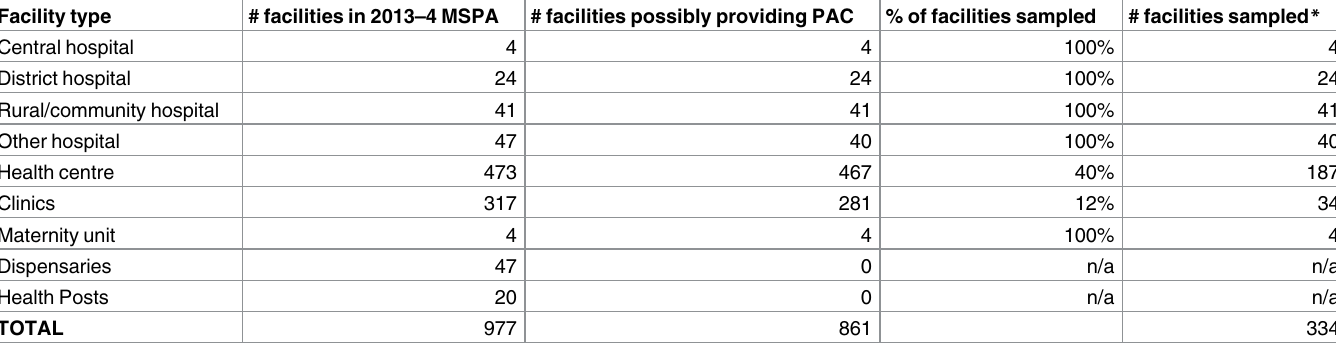
Table 1. Number of facilities sampled, Health Facilities Survey, Malawi